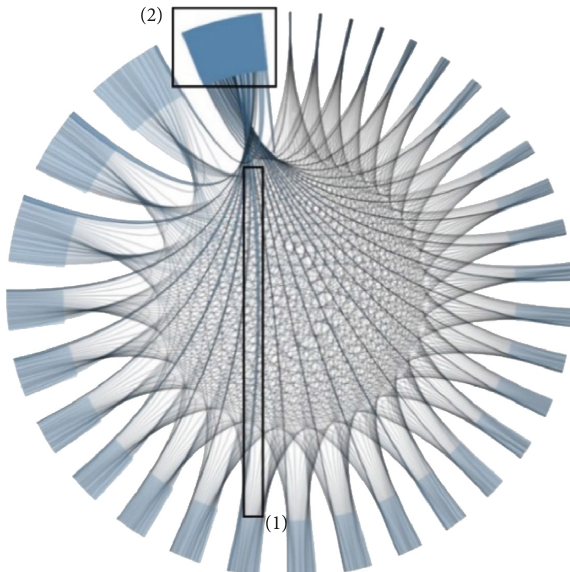
Figure 9: Visualization of chord diagrams based on data